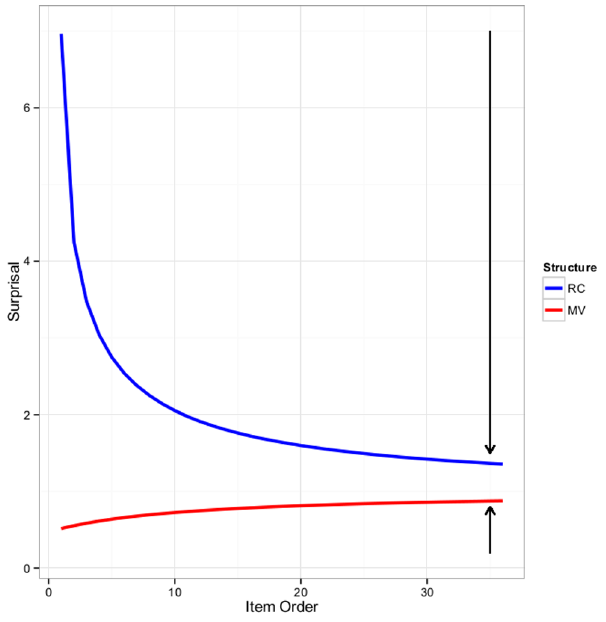
Figure 3. Predicted changes in surprisal for Experiment 1. Qualitative illustration of the changes in surprisal for MVs and RCs predicted by our account throughout Experiment 1. Black arrows indicate the predicted changes in surprisal at the end of Experiment 1: large changes for RCs (blue), but tiny changes for MVs (red).